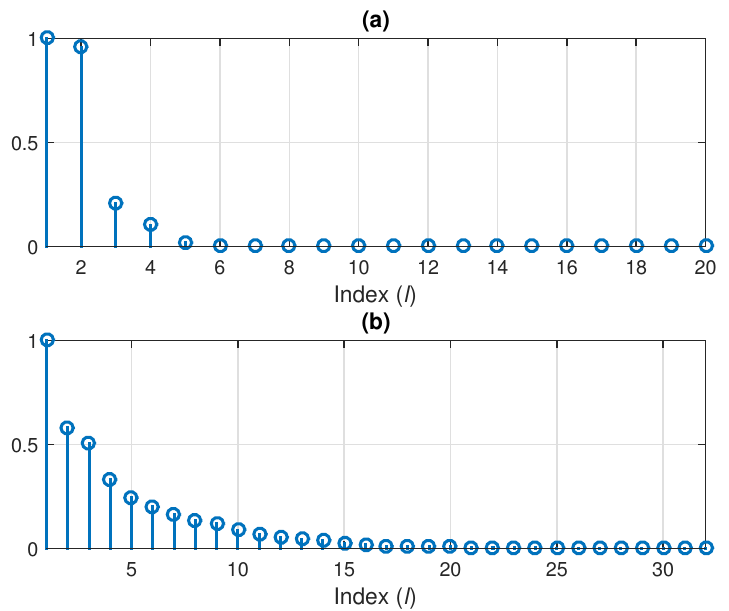
Figure 6. Singular values (normalized with respect to the maximum one) of the matrix H st , corre- sponding to ( a ) the impulse responses from Figure 3, with M = 4, L = 500, L 1 = 25, and L 2 = 20; and ( b ) the impulse responses from Figure 4, with M = 2, L = 1024, and L 1 = L 2 =